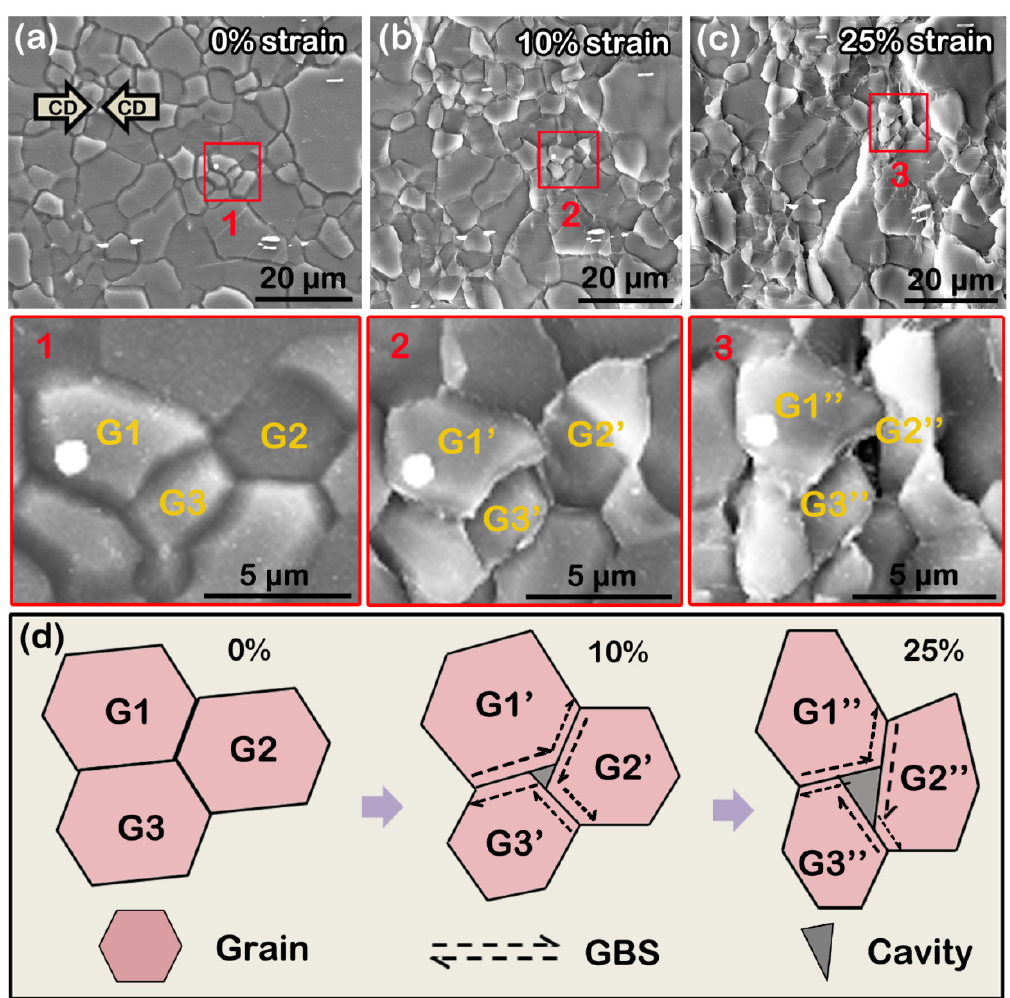
Figure 14. Quasi in situ SEM images of as-extruded AZ31 alloy subjected to hot compression at different strains: ( a – c ) 0, 10, and 25% strain, respectively. ( d ) Schematic diagram of formation and propagation of GBS-induced cavity.